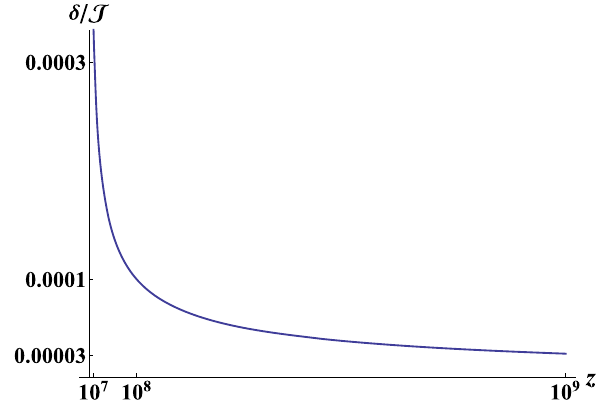
Fig. 2 Behavior of the parameter (15), in terms of z = r / r 0 and J = J /( mr 0 ) . The plots are for z (cid:7) 1, according to our approximations